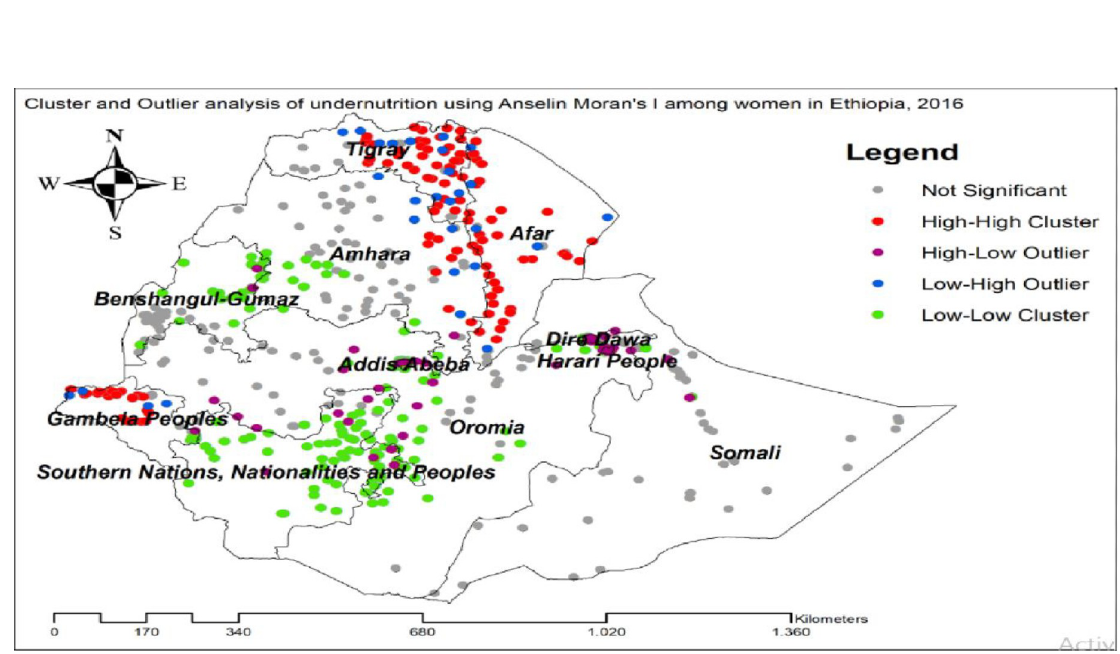
Fig 6. Cluster and outlier analysis of undernutrition using Anselin Moran’s I among reproductive age women in Ethiopia.